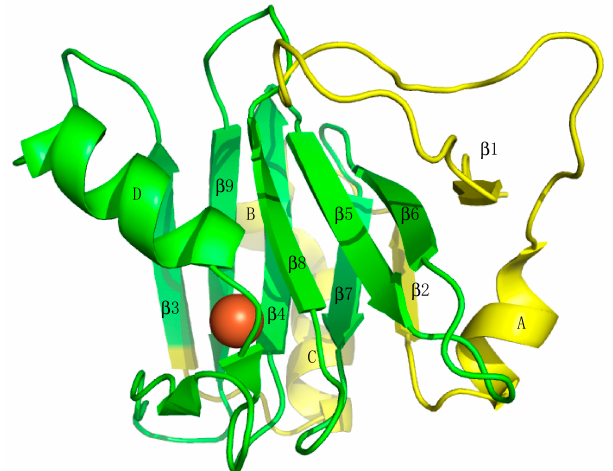
Figure 1. Crystal structure 4QGN [2] of HsARD (ADI1GP), showing arrangements of secondary structures referred to in the text. Residues in yellow are truncated in SipL